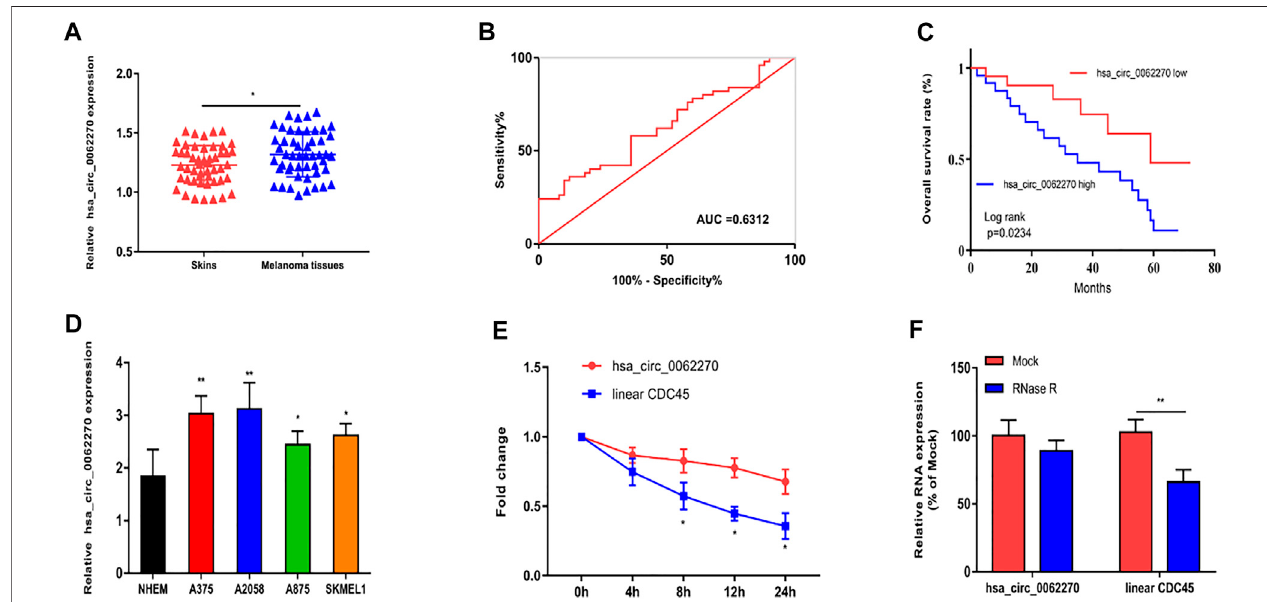
FIGURE 1 | Up-regulated hsa_circ_0062270 predicted poor prognosis in melanoma. (A) Expression of hsa_circ_0062270 in melanoma and normal skin tissues; (B) Diagnostic potential of hsa_circ_0062270 in melanoma; (C) Prognostic potential of hsa_circ_0062270 in melanoma; (D) Differential level of hsa_circ_0062270 in melanomacellsandnormalhumanepidermalmelanocytes; (E) Expressionchangesofhsa_circ_0062270andCDC45inA375cellstreatedwithActinomycinD; (F) Half- life of hsa_circ_0062270 and CDC45 in A375 cells treated with RNase R. * p < 0.05; ** p <